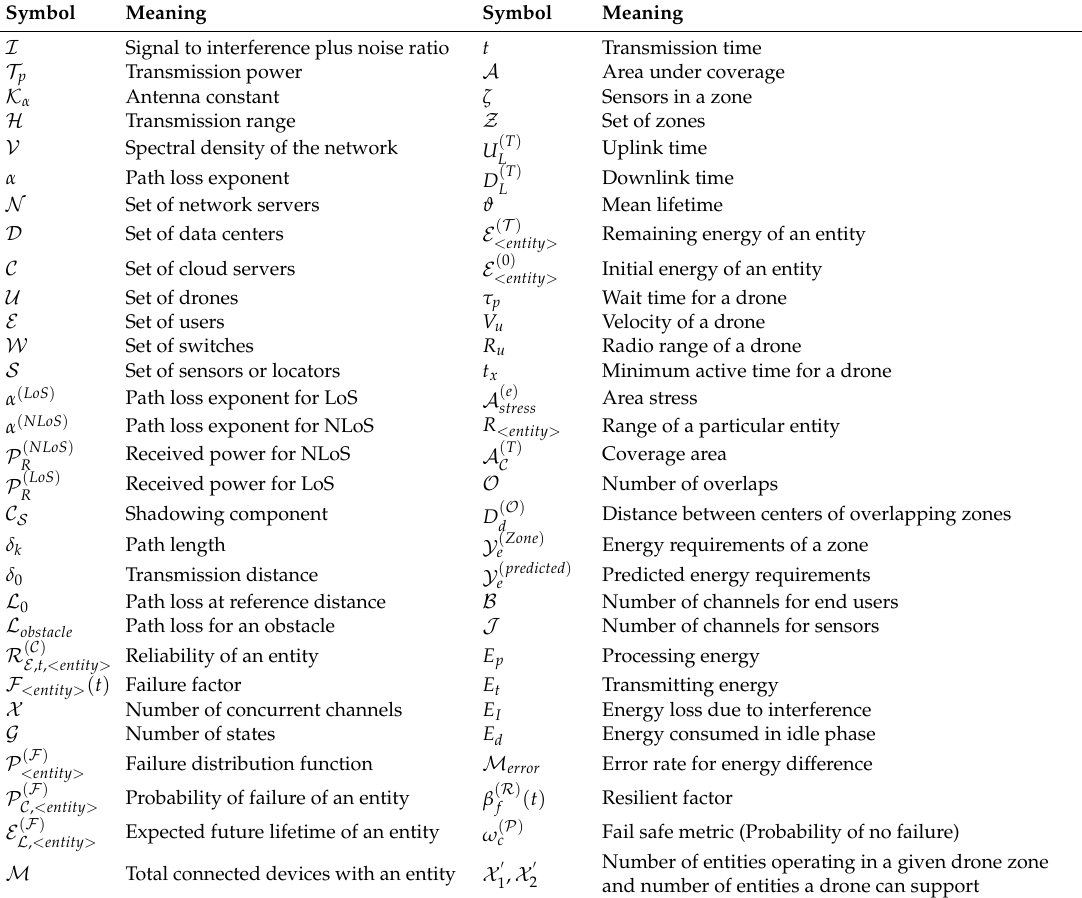
Table 1. Symbols used in the